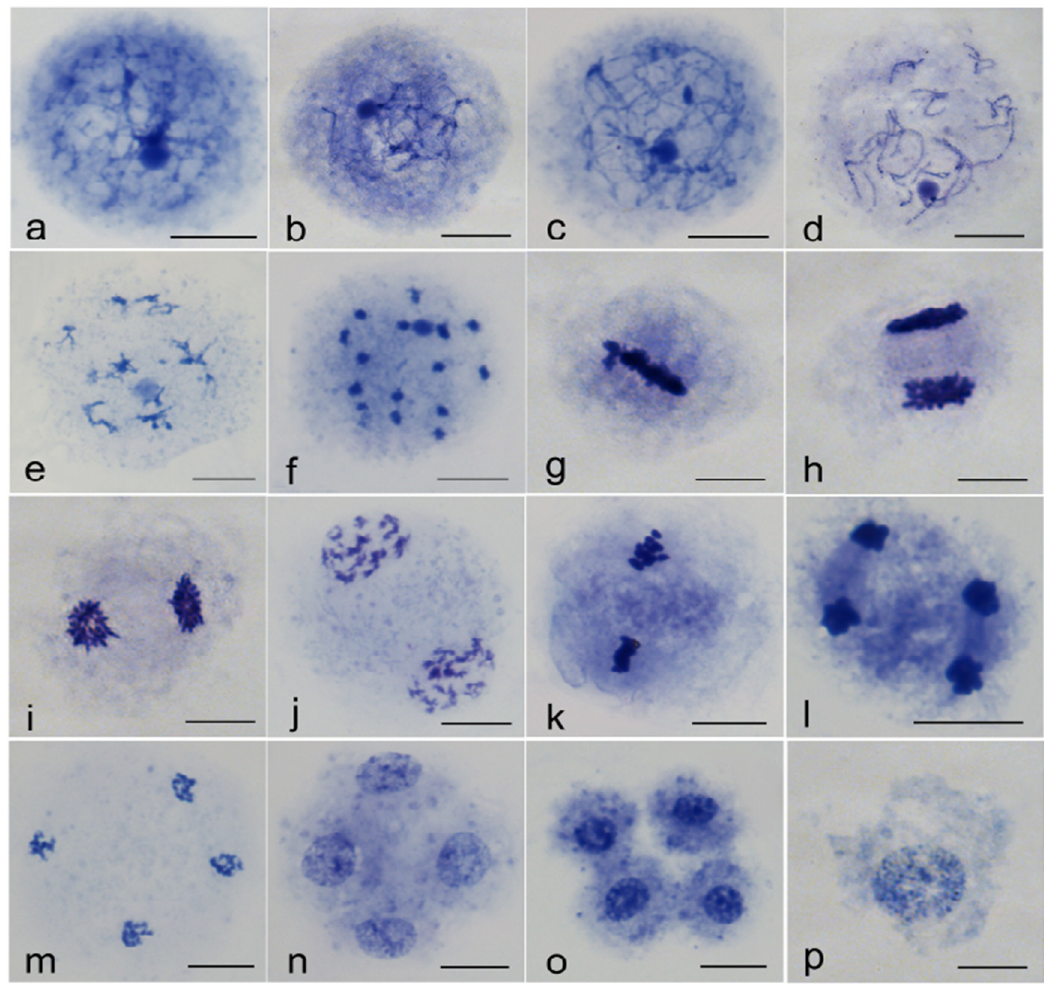
Figure 4. The process of meiosis in ‘Shixia’ microspore mother cells: ( a ) Early-leptotene, ( b ) Late- leptotene, ( c ) Zygotene, ( d ) Pachytene, ( e ) Diplotene, ( f ) Diakinesis, ( g ) Metaphase I, ( h ) Anaphase I, ( i ) Telophase I, ( j ) Prophase II, ( k ) Metaphase II, ( l ) Anaphase II, ( m ) Telophase II, ( n , o ) Tetrad, ( p ) Microspore. Scale bar = 10 µ